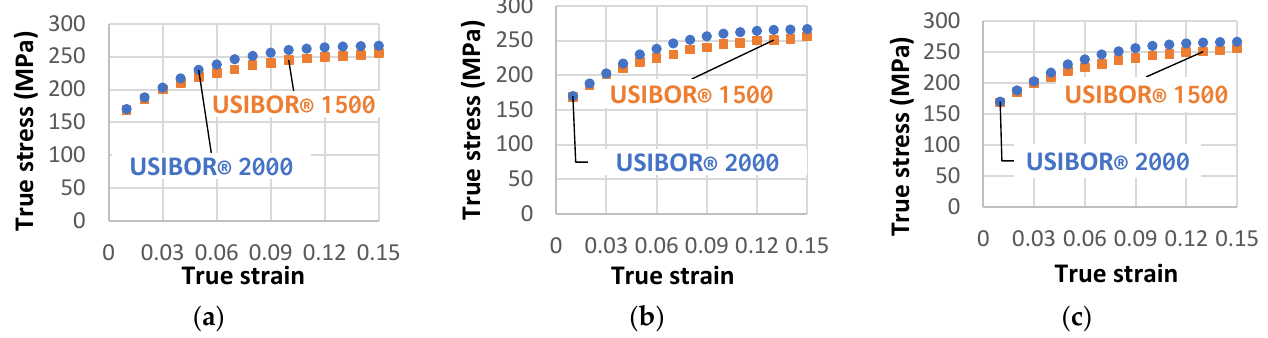
Figure 18. Comparison between the two investigated UHSS at the strain rate of 1 s − 1 and the test temperature of ( a ) 750 °C, ( b ) 800 °C and ( c ) 850 °C.